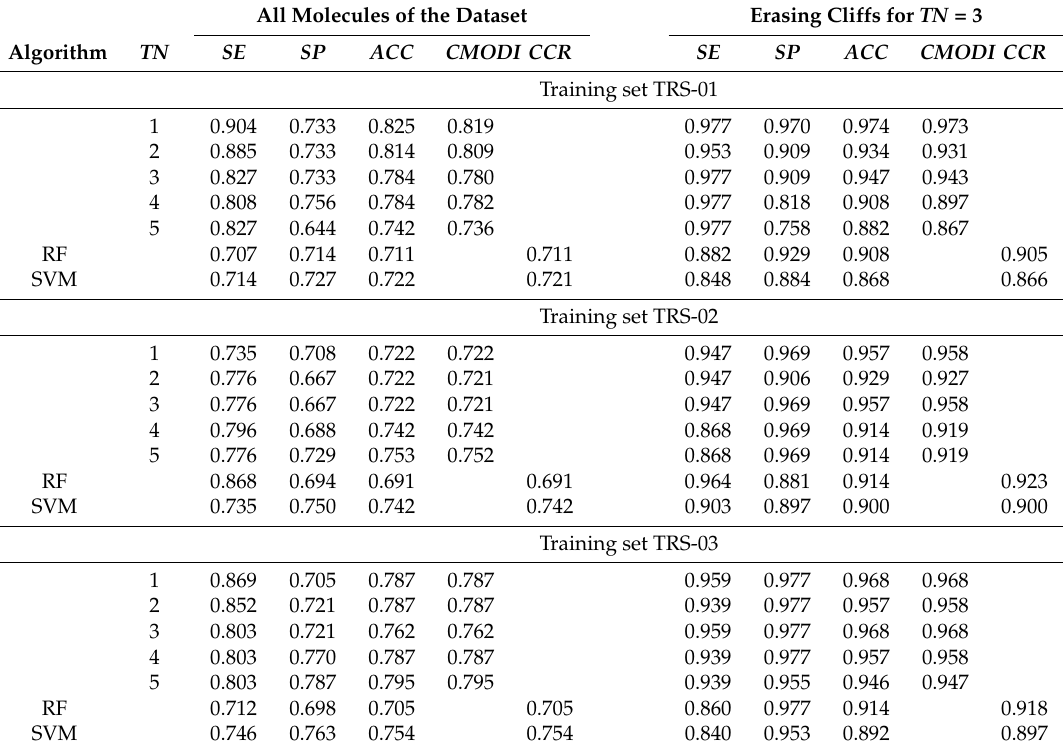
Table 4. Results of the MRP4 predictions using CMODI for different values of TN and the algorithms for the three whole training sets and the training sets erasing the activity cliffs detected for TN = 3. All Molecules of the Dataset Erasing Cliffs for TN =